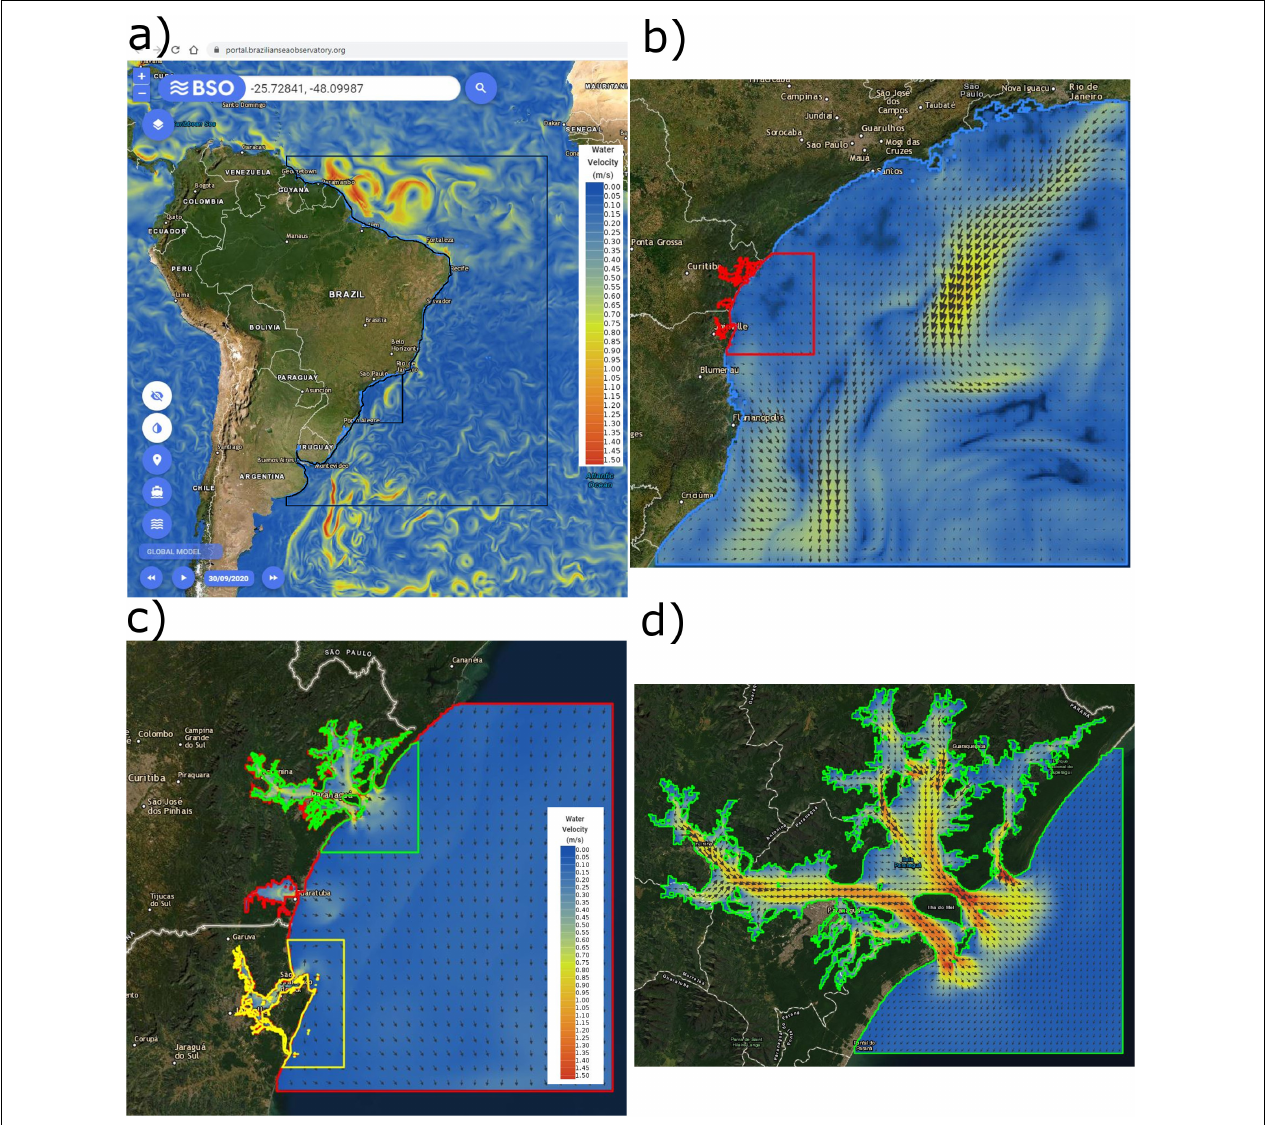
FIGURE 6 | View of the WebGIS platform: forecasts from the CMEMS global model (a) , south-eastern Brazilian shelf model (b) , Santa Catarina and Paraná coastal model (c) , Paranaguá Estuarine Complex model (d)